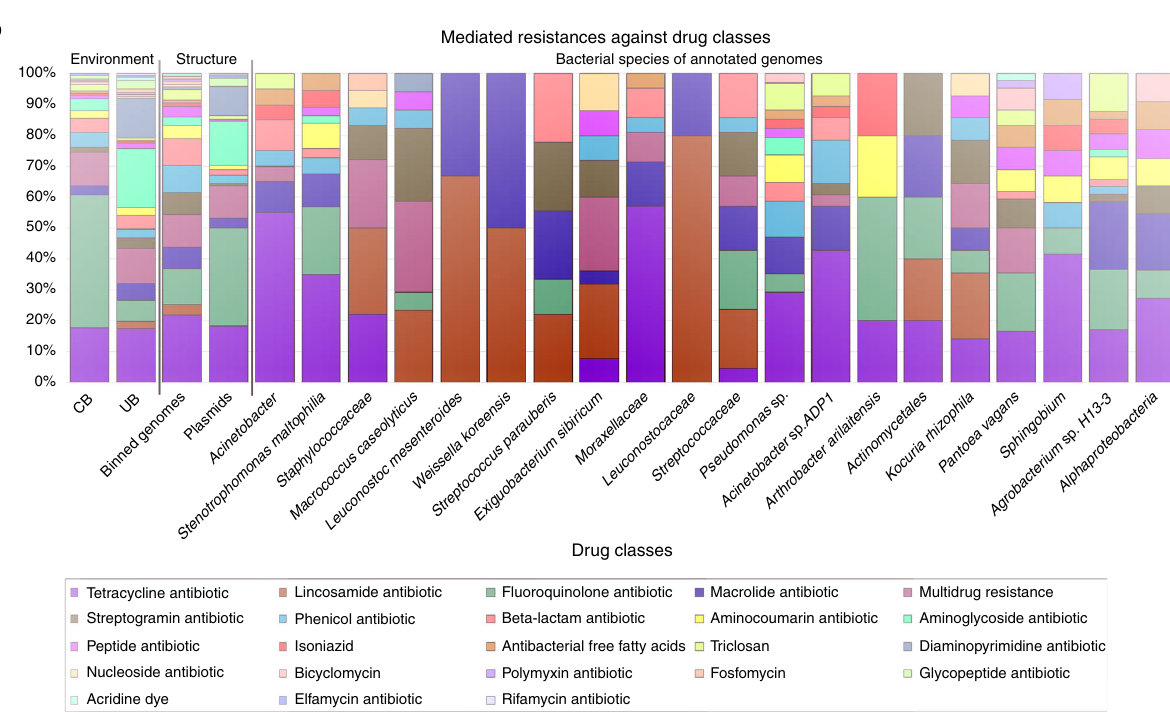
Fig. 7 Proportion of CARD categories and drug classes. a Higher categories of the resistome according to CARD per environment (CB and UB), nucleotide structure (binned genomes and plasmids), and for individual binned genomes (referring to individual species). b Drug classes and their conferred resistance to them according to CARD per environment (CB and UB), nucleotide structure (binned genomes and plasmids), and for individual binned genomes (referring to individual species). CARD, Comprehensive Antibiotic Resistance